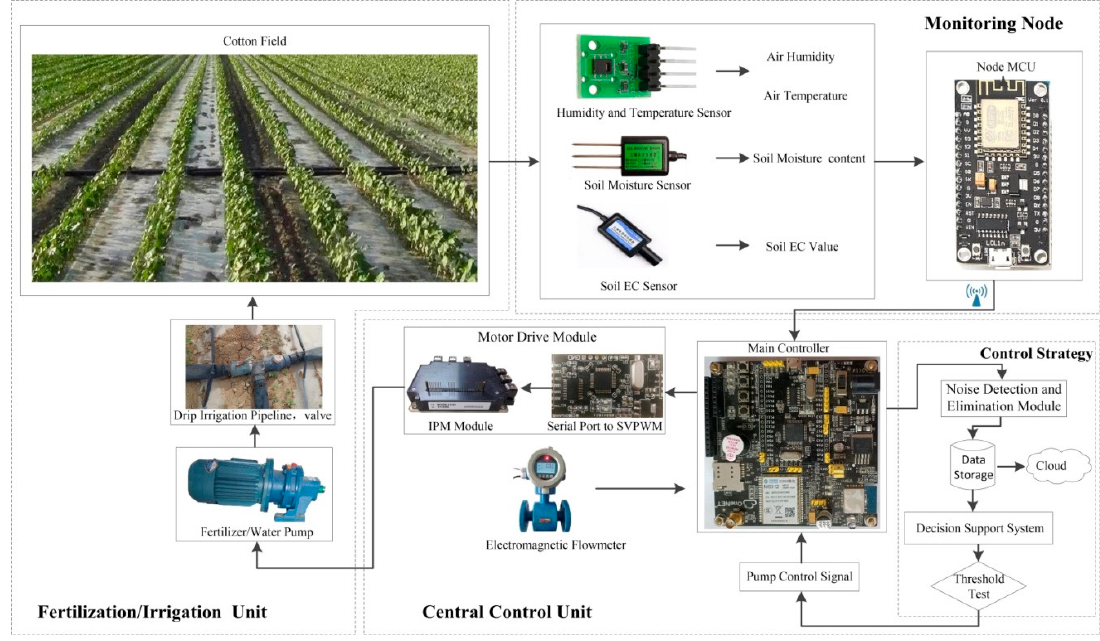
Figure 1. The proposed structure of the water-fertilizer control system.